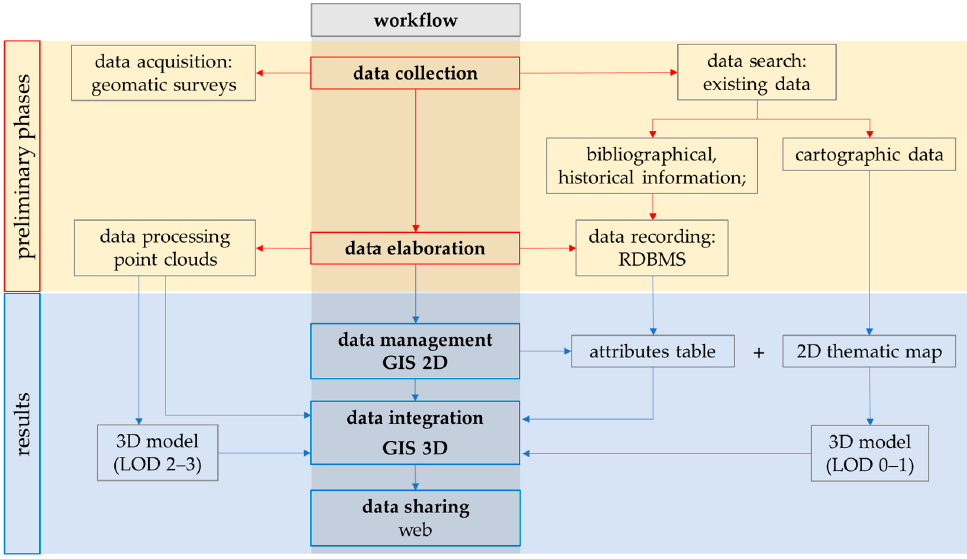
Figure 1. Methodological workflow.